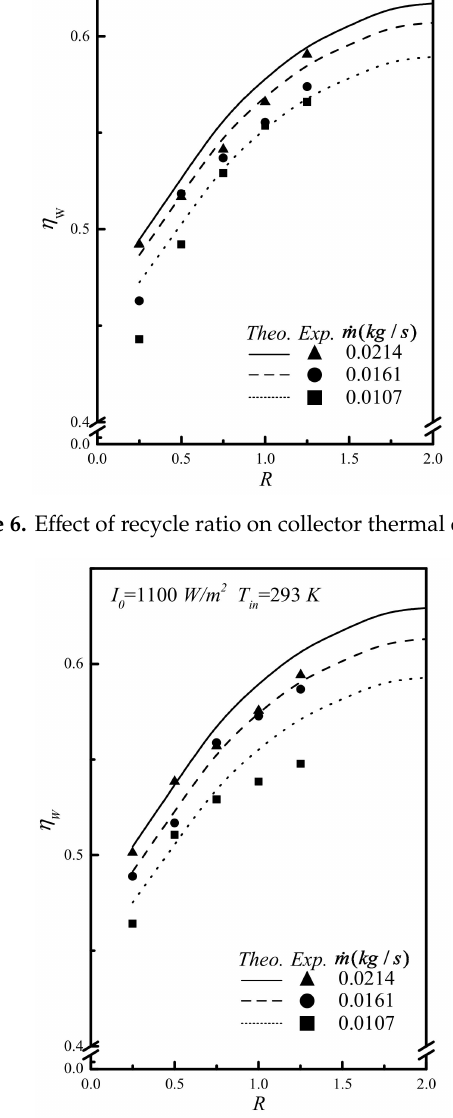
Figure 7. E ff ect of recycle ratio on collector thermal e ffi